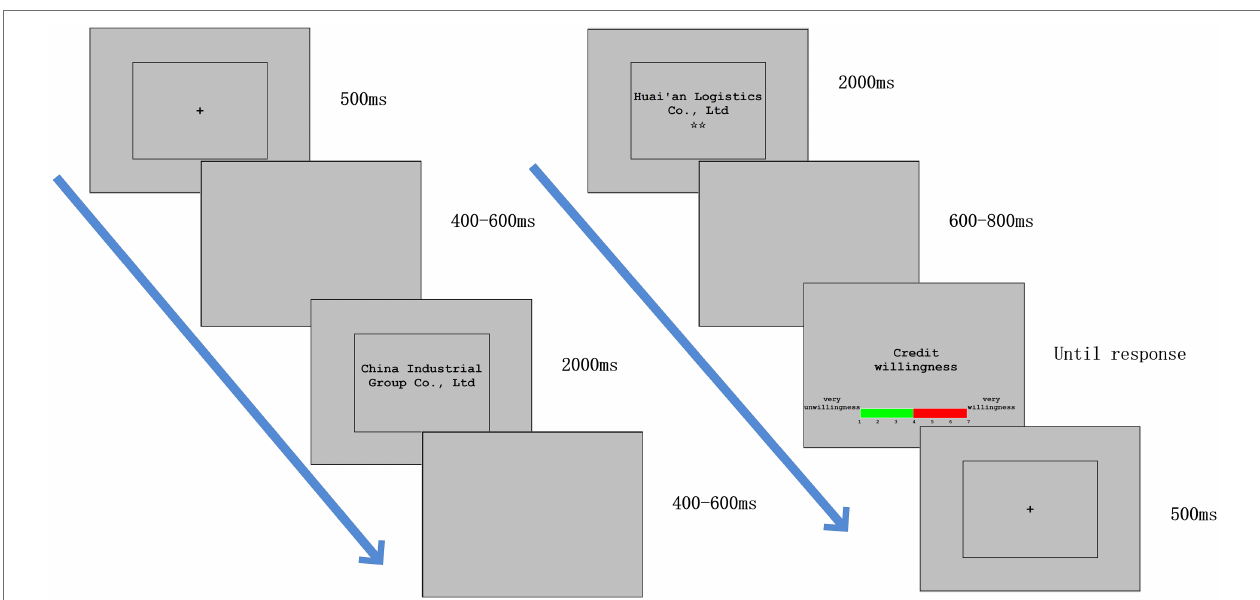
FIGURE 1 | Experimental task: Participants were instructed to determine whether to grant credit based on the scale of 3PL guaranteeing